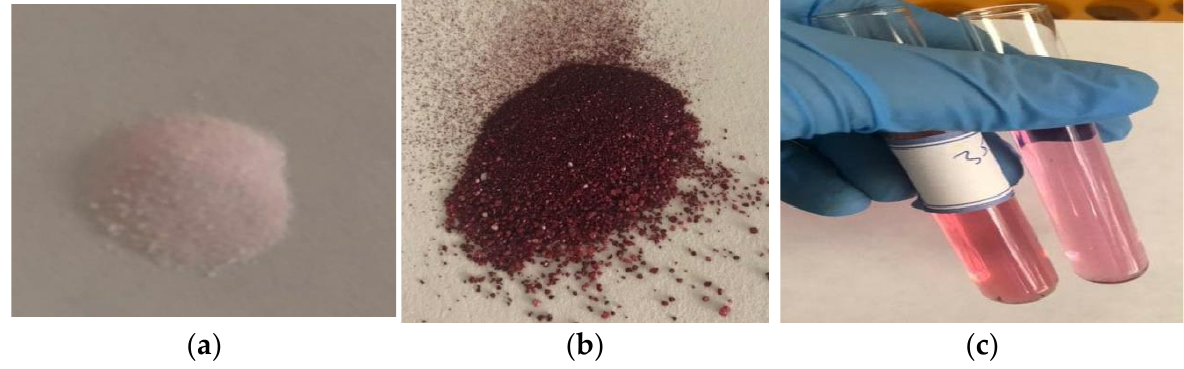
Figure 13. B-ZnO/TiO 2 changes during DR16 adsorption: before adsorption ( a ), after adsorption ( b ), and (c) color changes in DR16 solution (35 ppm) after 180 min adsorption. Table 6. Kinetic parameters of DR16 adsorption by B-ZnO/TiO 2 .